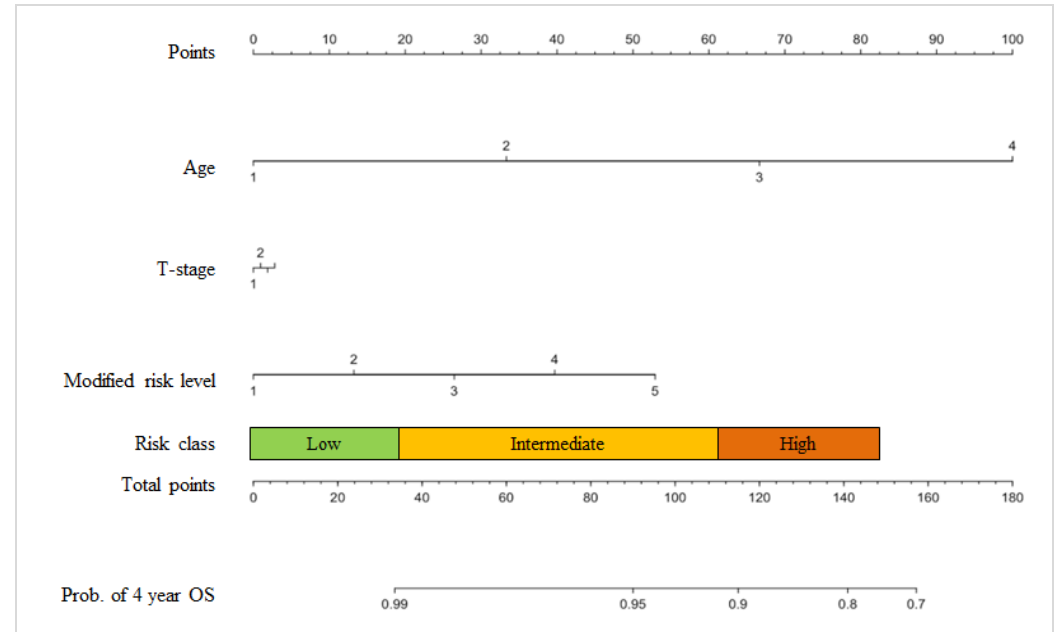
Figure 1. PCO nomogram. Age (years): 1 = under 59, 2 = 60–69, 3 = 70–79, and 4 = over 80; T-stage: 1 =